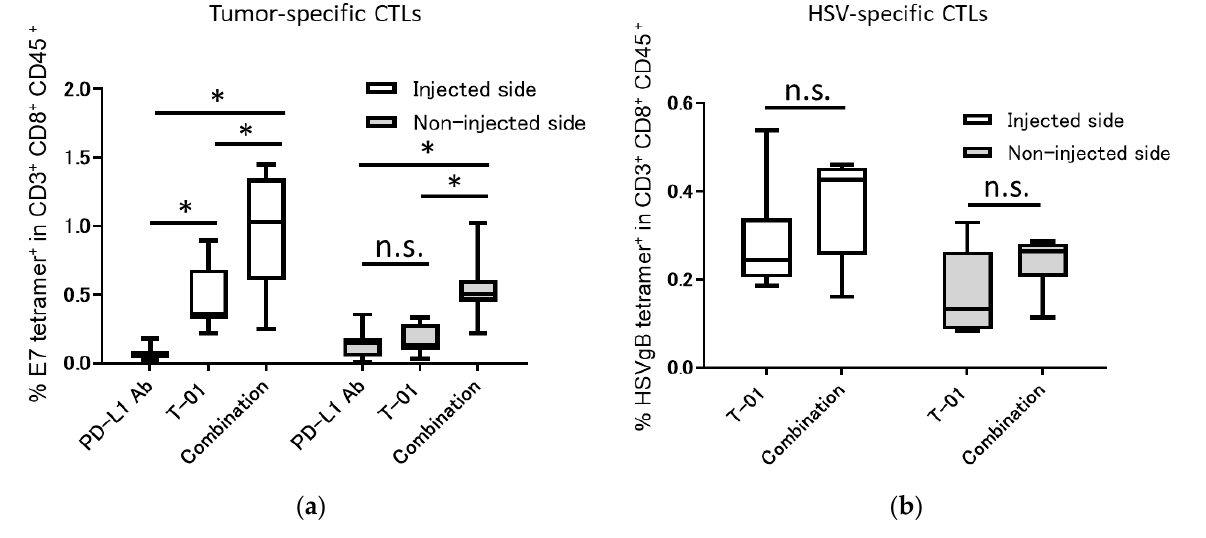
Figure 3. Tumor-specific and HSV-specific CTLs in bilateral subcutaneous TC-1 tumors treated with the combination of T-01 and anti-PD-L1 Ab. Thirteen days after tumor implantation, tumors were harvested and characterized for the presence of E7-specific CD8+ T-cells and HSV- specific CD8+ T-cells using E7-specific tetramer and HSV gB tetramer staining followed by flow cytometry analysis. ( a ): Tumor-infiltrating E7-specific CD8+ T-cells were analyzed by flow cytometry. ( b ): Tumor-infiltrating HSV-specific CD8+ T-cells were analyzed by flow cytometry. The results are presented as boxplots, which display the dataset based on the five-number summary: minimum, maximum, sample median, and the first and third quartiles ( n = 8 per group). A two-way ANOVA fol- lowed by Sidak’s multiple comparisons test was used to determine statistical significance (* p < 0.05, n.s.: not significant).